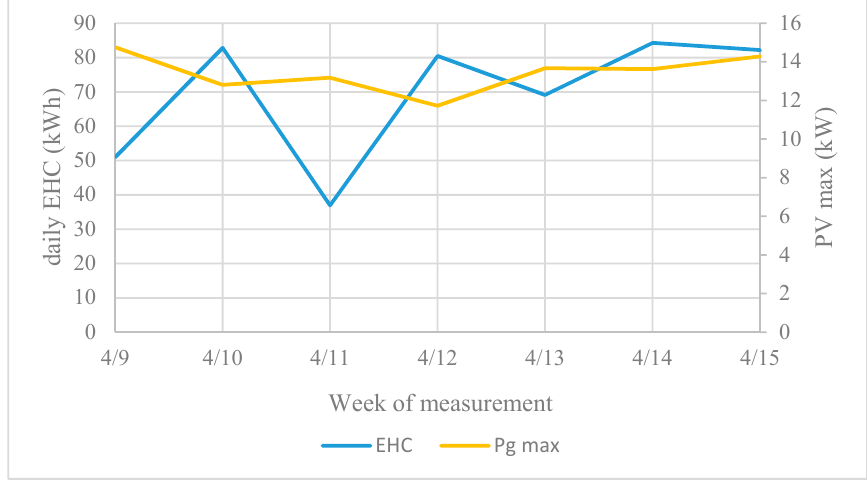
Figure 14. Daily EHC profile versus maximum PV generation.